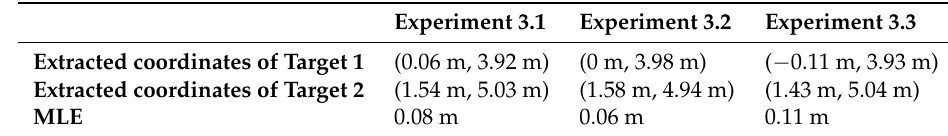
Figure 15. Photographs and geometries of Experiment 3: ( a ) Experiment 3.1 with orientation angle of 90 ◦ for Target 2; ( b ) Experiment 3.2 with orientation angle of 30 ◦ for Target 2; and ( c ) Experiment 3.3 with orientation angle of 0 ◦ for Target 2. Table 4. Localization results and MLE of Experiment